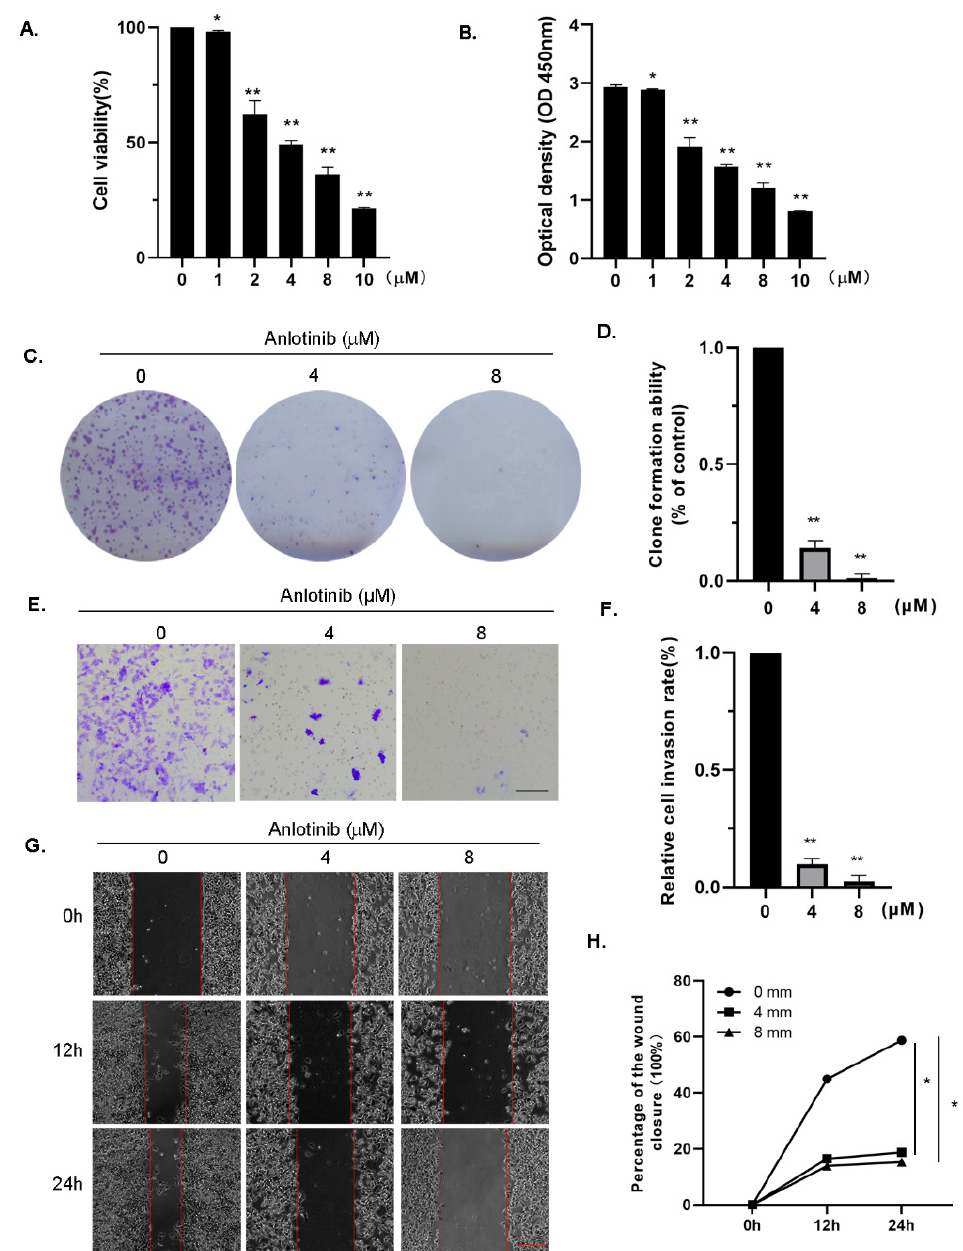
Figure 1. Anlotinib inhibits proliferation, migration, and invasion of ovarian cancer cells in vitro. ( A , B ) A2780 cells were treated with different concentrations (0,1, 2, 4, 8, and 10 µ M) of anlotinib for 72 h. The cell-counting kit-8 assay was performed. ( C , D ) Representative images of colony-formation assay. ( E – H ) The effects of anlotinib on cell invasion and migration were measured using wound- healing ( E , F ) and transwell assays ( G , H ). All experiments were performed in at least three biological replicates, and each biological replicate contained three technical replicates. Student’s t -test was used to compare values between control and different treatment groups. * p < 0.05, ** p < 0.01 vs. control group. OD, optical density. Scale bars = 100 µ